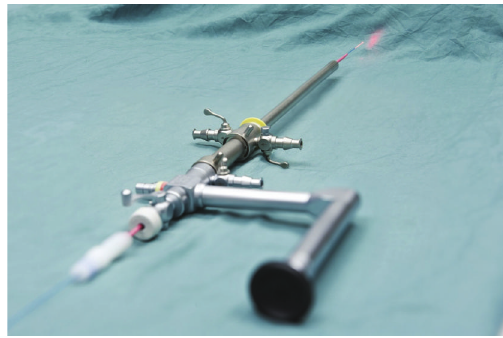
Figure 2: A photograph of the nephroscope setup: a 365 µ holmium laser fiber (SlimLine 365 micron Blue Jacket Reusable Fiber; Lume- nis Inc., Santa Clara, CA) stabilized with a 7 F ureteral catheter (Cook, Bloomington, IN) and used through the indirect nephro-